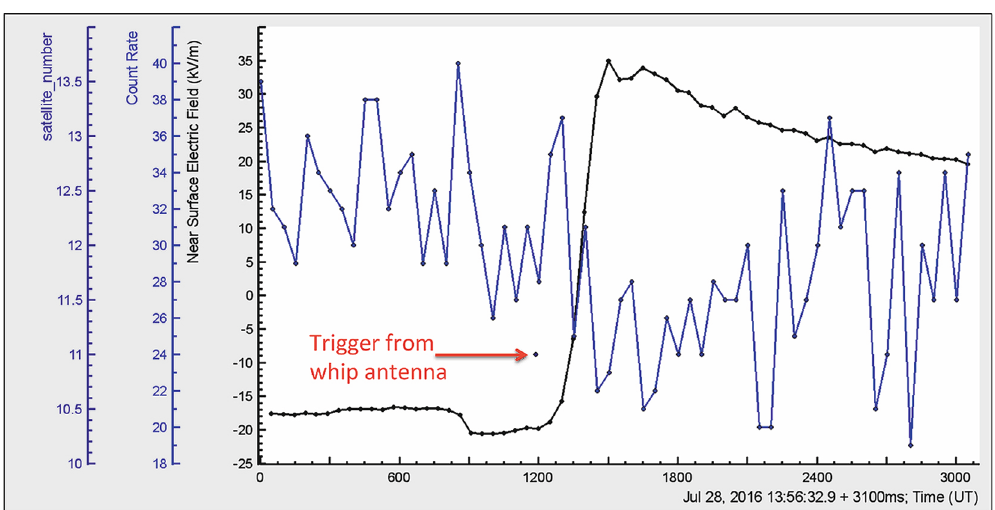
Figure 3. 50 ms time series of MAKET upper 1-cm thick scintillator count rate and electrostatic field. The time of trigger is denoted by a point occurred at 13:56:34.087 UT (calculated by 11 GPS satellites). WWLLN registered lightning at 13:56:34.087 UT. The electric field starts to rise ~50 ms after trigger, reaching maximum ~200 ms later; the amplitude of the electric field change was ~48.6 kV/m. Particle flux starts to decline at 11:56:34.2